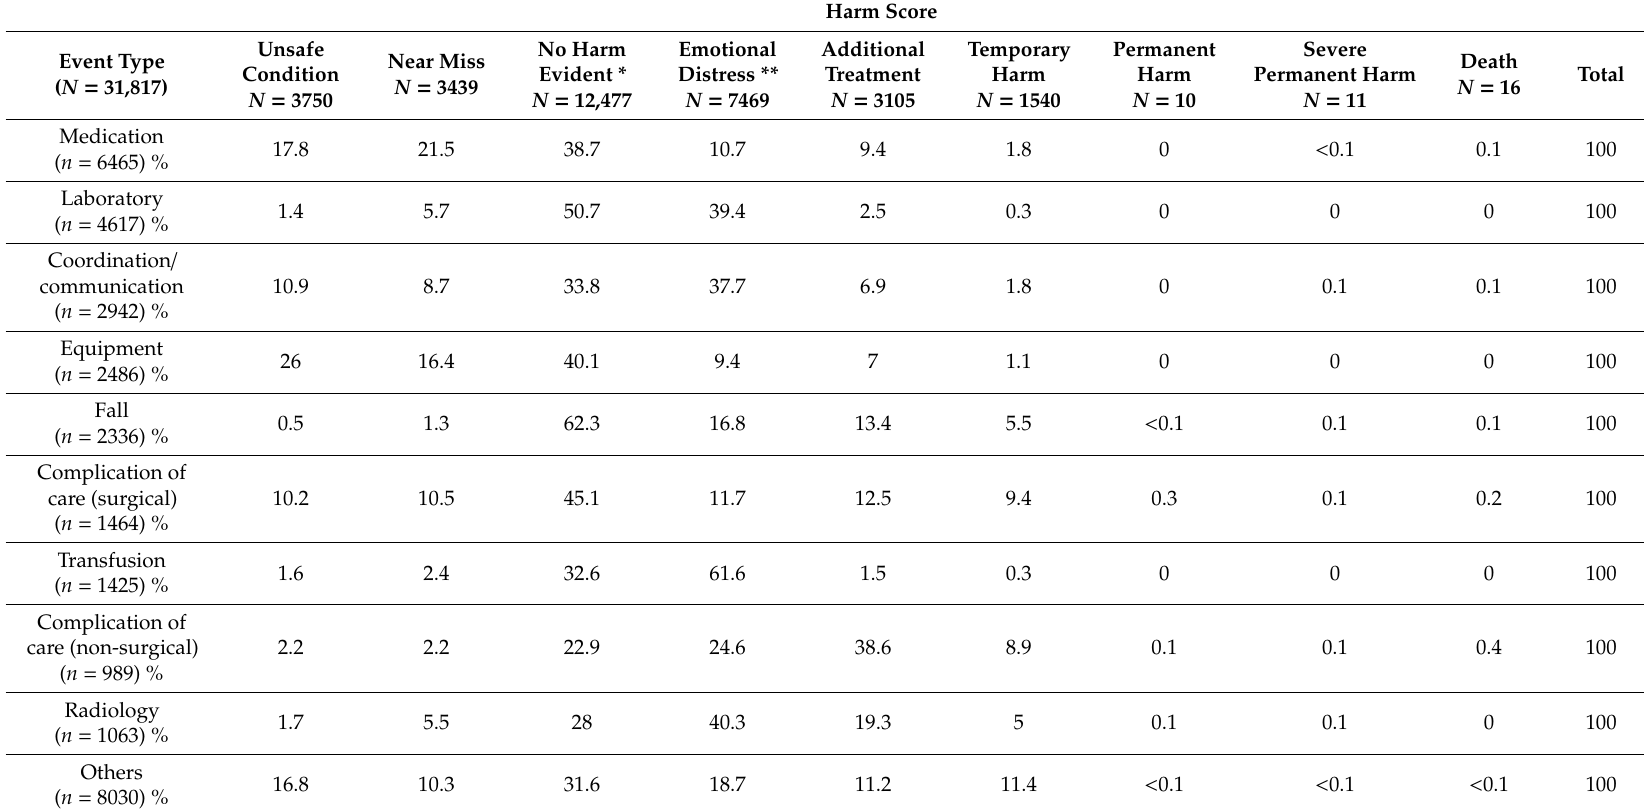
Table 5. Harm score and event type (percentage within event